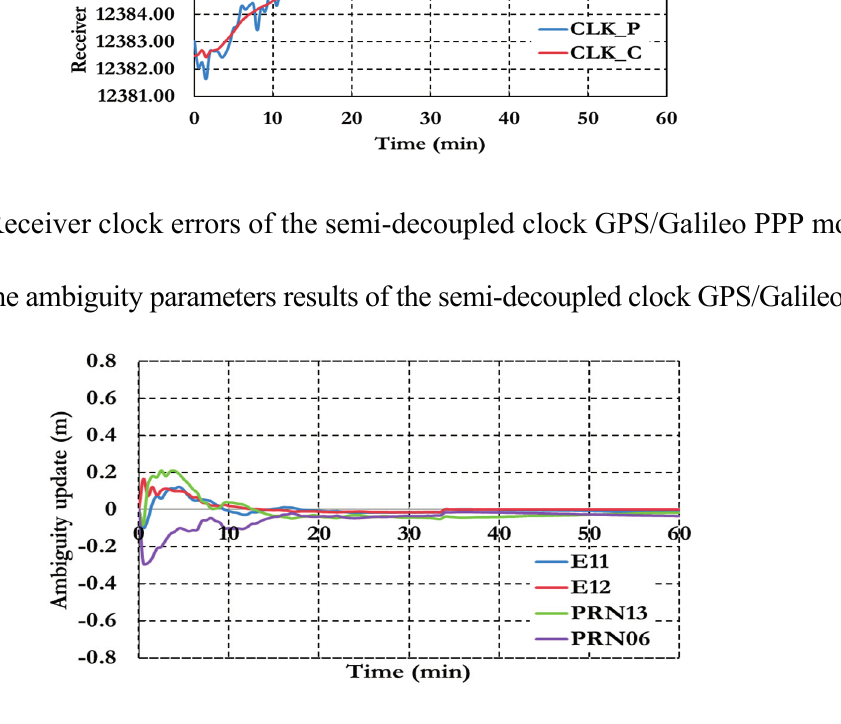
Figure 14. Ambiguity parameters of the semi-decoupled clock GPS/Galileo PPP